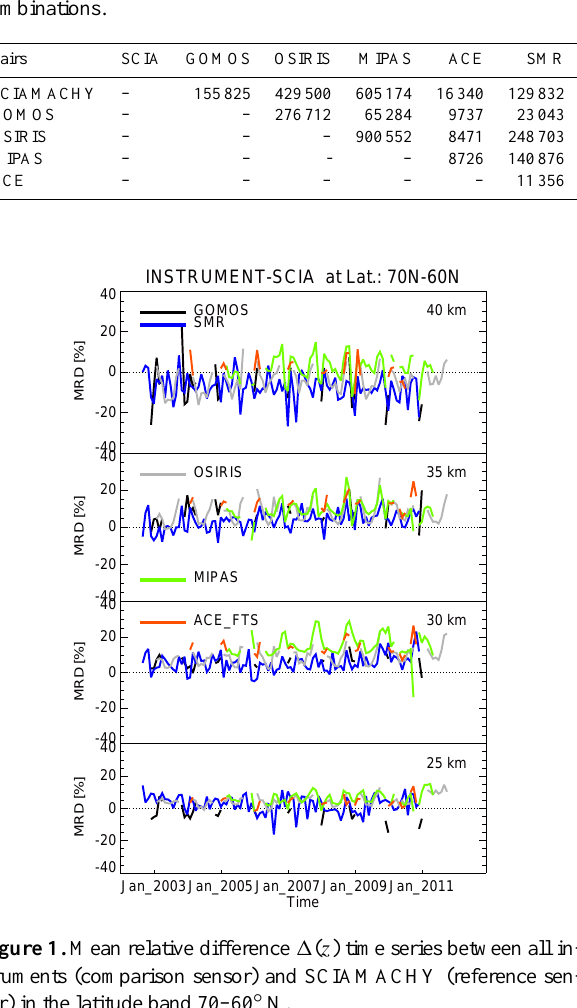
Table 3. Number of total collocations (90 ◦ S–90 ◦ N) for pairwise combinations.